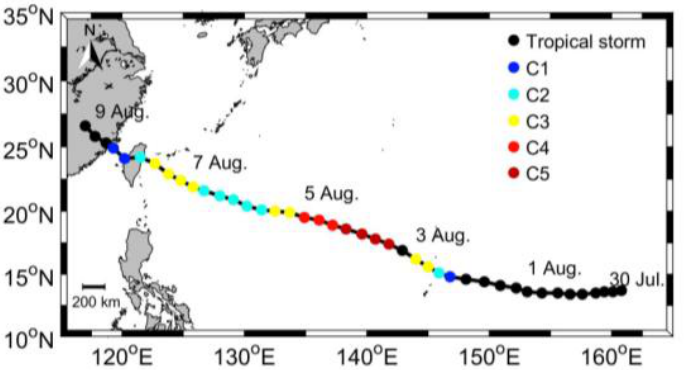
Figure 1. Track and intensity of Super Typhoon Soudelor in August 2015. Dots denote the 6-hourly typhoon center positions with the color indicating the typhoon intensity categorized by the Saffir- Simpson scale.